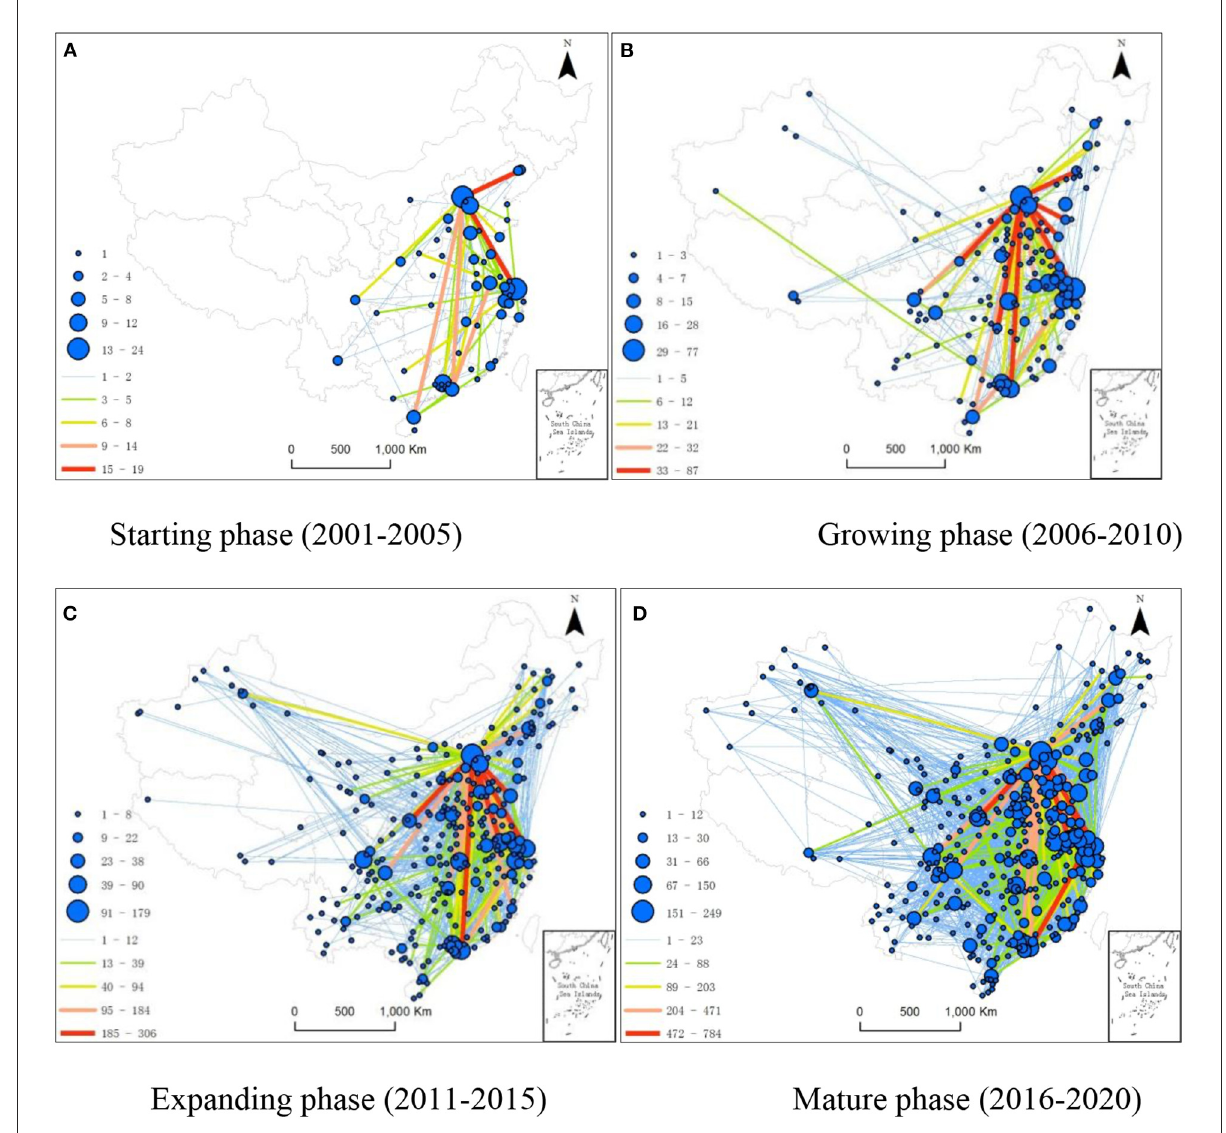
FIGURE1 Spatiotemporal Evolution of the Chinese National Urban Biomedicine Innovation Network during the time span of 2001–2020. (A) Starting phase (2001–2005). (B) Growing phase (2006–2010). (C) Expanding phase (2011–2015). (D) Mature phase